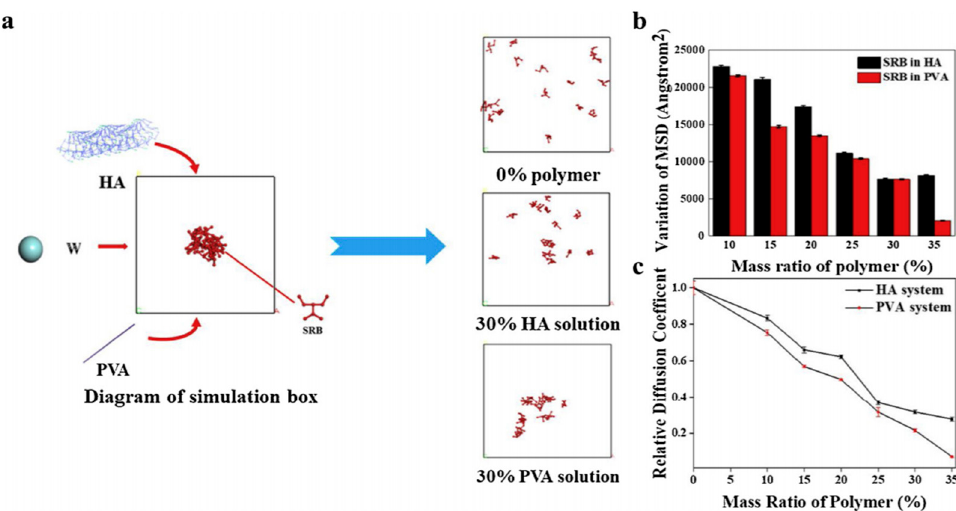
Figure 18. ( a ) Sketch to illustrate difference in diffusion behaviour of Sulforhodamine in different polymer solutions and ( b ) the variation of mean square displacement (MSD) mean square displacement (MSD) for Sulforhodamine (SRB) and ( c ) the relative diffusion coefficient of SRB (adopted from [140]).